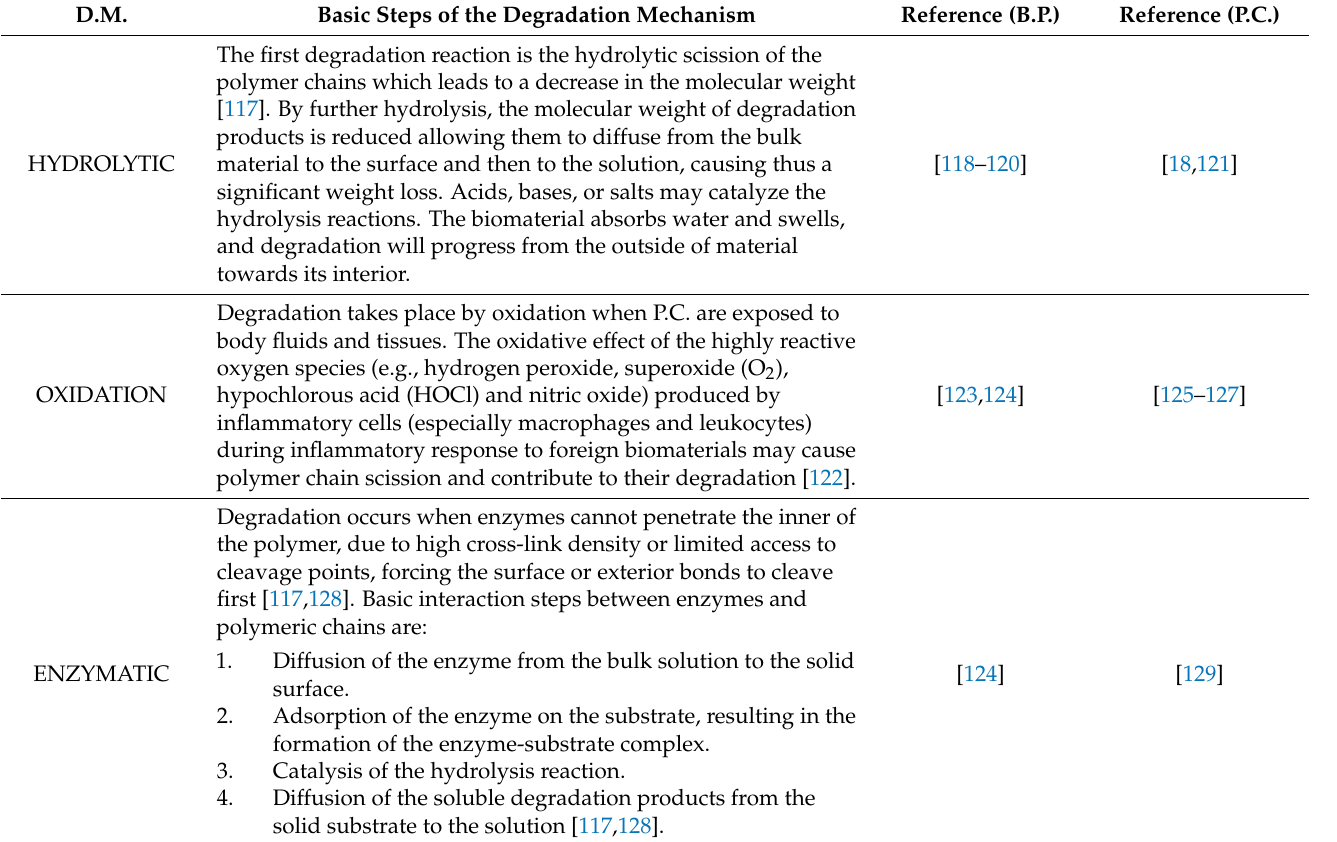
Abbreviations of the table legends: Degradation mechanism type =